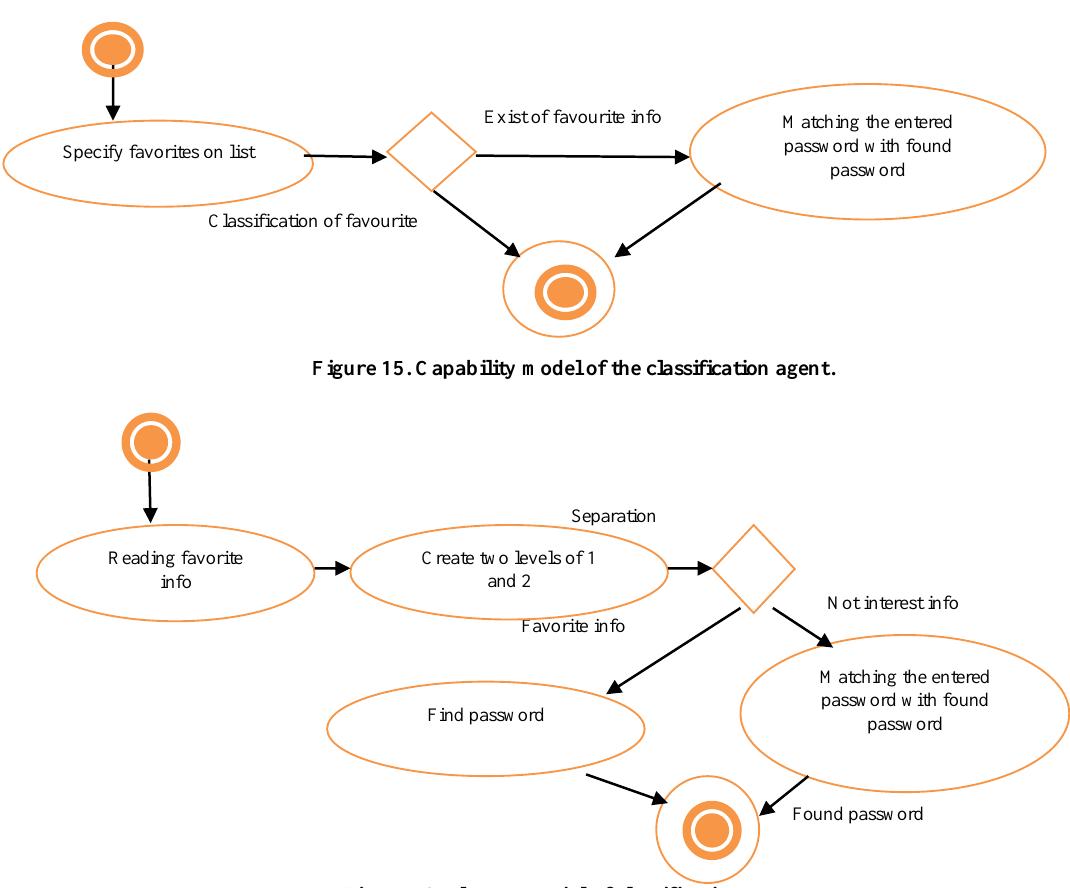
Figure 16. Planner model of classification agent.